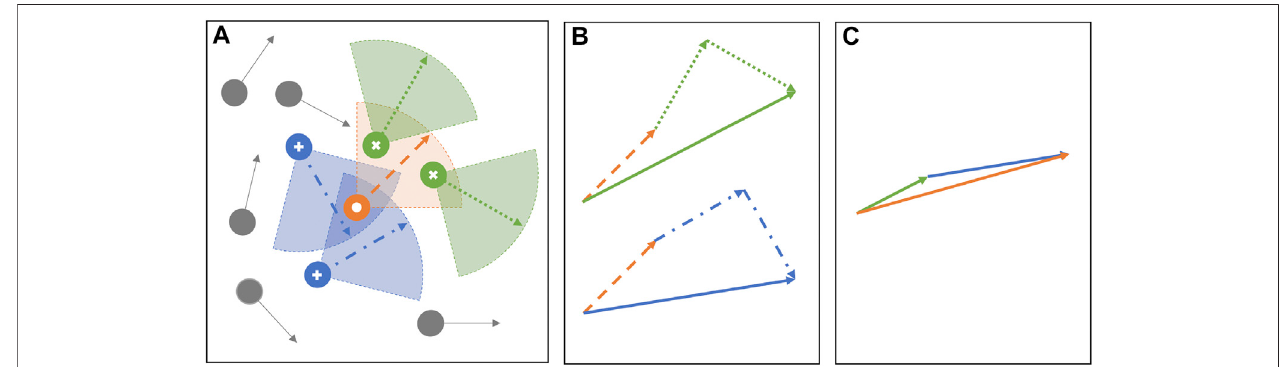
FIGURE1|(A) Theschematicshowstheauditoryandvisualsensingschemesforatargetindividual(whitecircle).The “ visualneighbors ” aretheindividualsthatthe target “ can see ” and are marked using cross symbols. The “ auditory neighbors ” are the individuals that the target “ can hear from ” and are marked with plus symbols. In the present model, the auditory and visual sensing sectors are assumed to be geometrically similar having same r and ϕ for a given simulation. (B) Shows the vectorial addition of the heading directions from the two independent sensing modes, vision (top) and audition (bottom) . Note that the heading direction (dashed orange vector) of the target appears in the vectorial addition of both the modes, allowing the total contribution from itself to be one. The resultant vector from vision (green solid vector) and audition (blue solid vector) averages the heading direction of visual and auditory neighbors, respectively. Finally (C) shows an example heading direction update in the next time step using the weighted protocol, with α a (cid:2) 2/3 and α v (cid:2) 1/3. Thus, the heading direction of the individual is computed by scaling the resultant vector of vision by one-third (one-third length of the green solid vector in B) and the resultant vector of audition by two-thirds (two-thirds length of the blue solid vector in B), followed by the vectorial addition. The solid orange arrow is the updated heading direction of the target at the next time